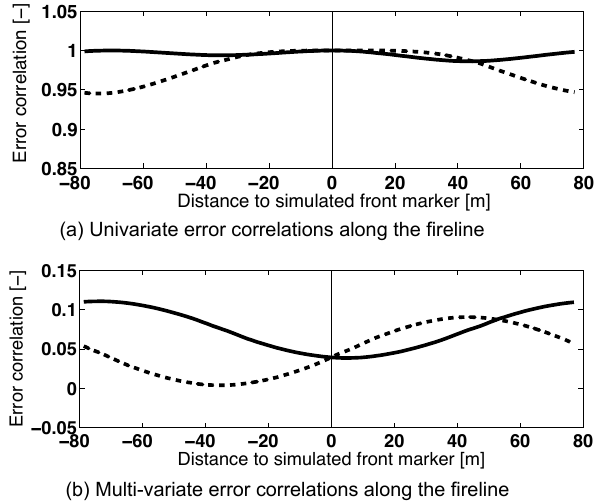
Figure 4. Error correlation functions along the fireline associated to one marker location (the vertical bar represents its reference lo- cation indexed by m in Fig. 3a) for the OSSE isotropic propagation test with constant ROS but uncertain ignition location ( x ign , y ign ) at the observation time t = 200s. (a) Univariate correlations: the dashed (solid) line indicates the error correlation of the reference marker x coordinate ( y coordinate) with respect to the errors in the x coordinates ( y coordinates) of the other markers along the fire- line. (b) Multi-variate correlations: the dashed (solid) line indicates the error correlation of the reference marker x coordinate ( y coordi- nate) with respect to the errors in the y coordinates ( x coordinates) of the other markers along the